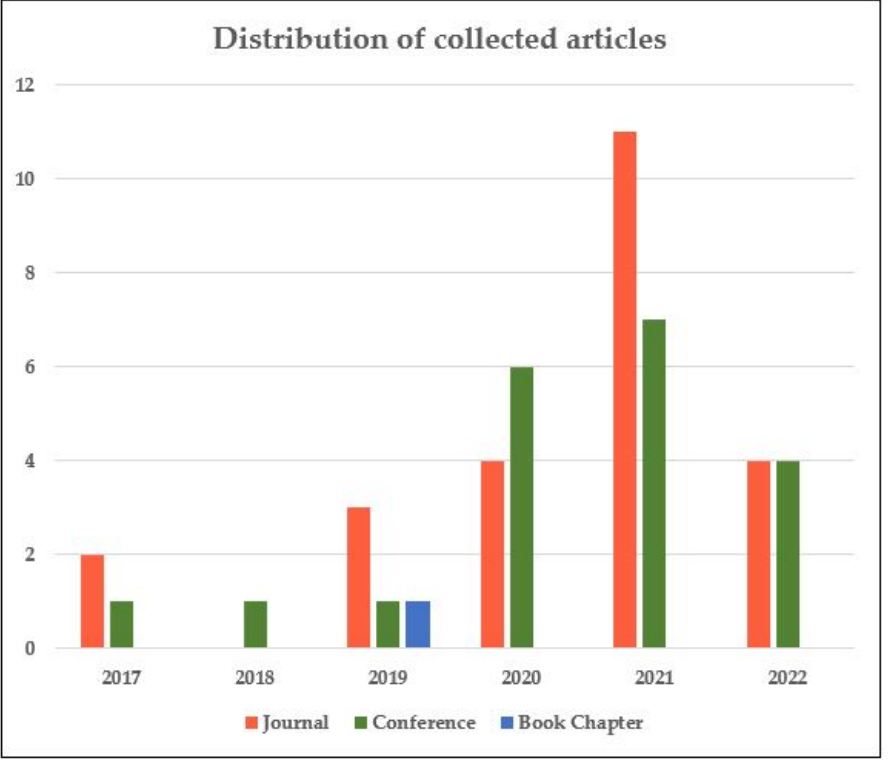
Figure 20. Distribution of reviewed papers by type and year.